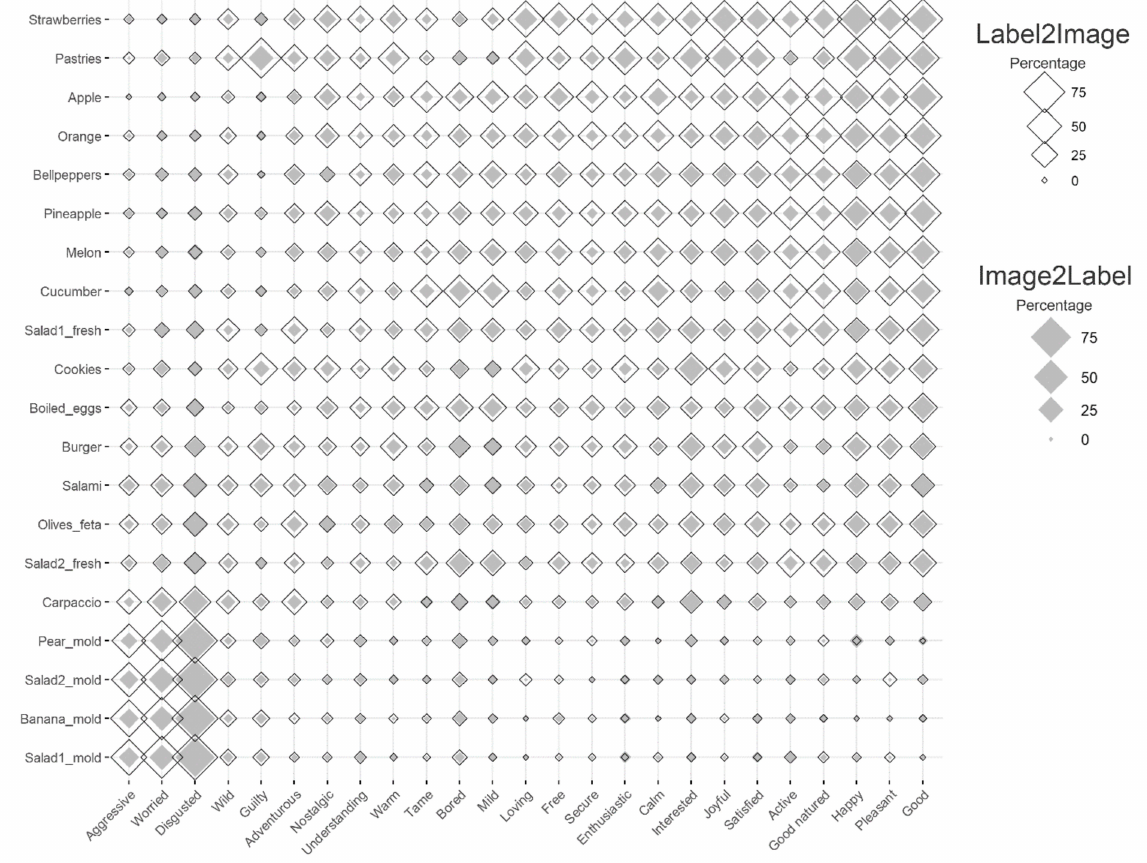
Figure 10. Percentage (represented by symbol size, ranging between 0% and 100%) of participants ( n = 480) that linked each image to a subset of the EsSense25 terms (Image2Label task, filled dia- monds), and each EsSense25 term to a subset of the food images ( Label2Image task, open diamonds). Emotions terms and food images are arranged in increasing average valence order along the horizon- tal and vertical